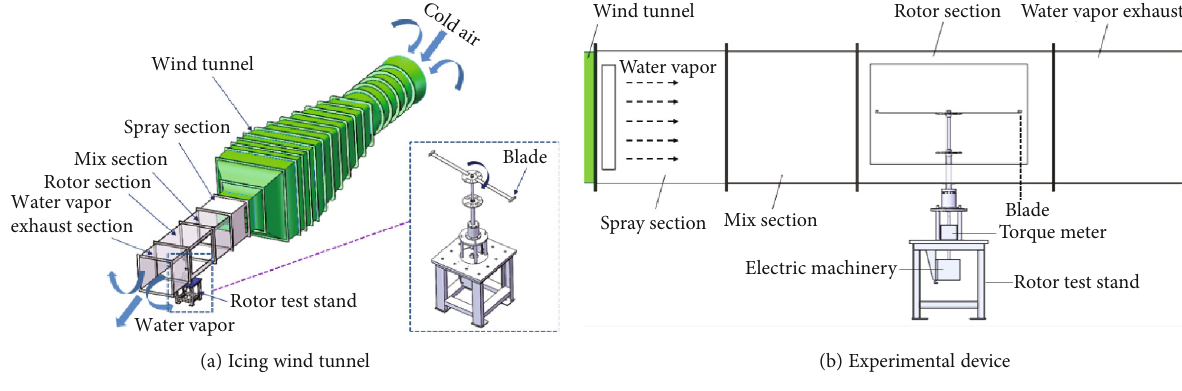
Figure 1: Icing wind tunnel system facility. Table 1: Key characteristic parameters of the icing wind tunnel.